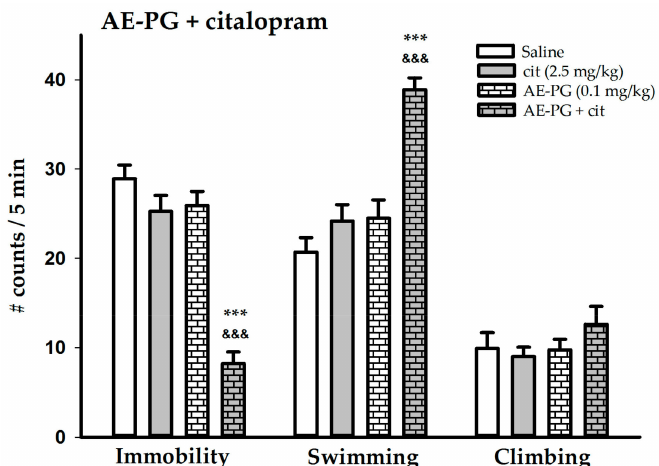
Figure 3. Behavioral effects of the simultaneous administration of the suboptimal dose of the AE-PG (0.1 mg/kg) plus the suboptimal dose of the citalopram (2.5 mg/kg) (chronic administration for 14 days;